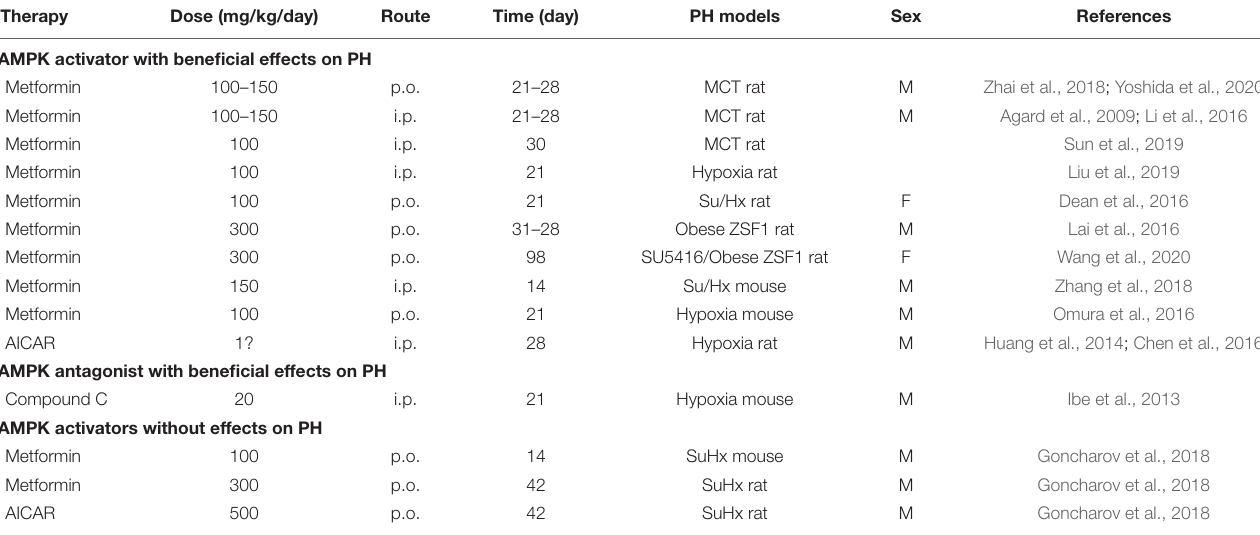
TABLE 2 | Pulmonary hypertension (PH) animal experiments of AMPK.